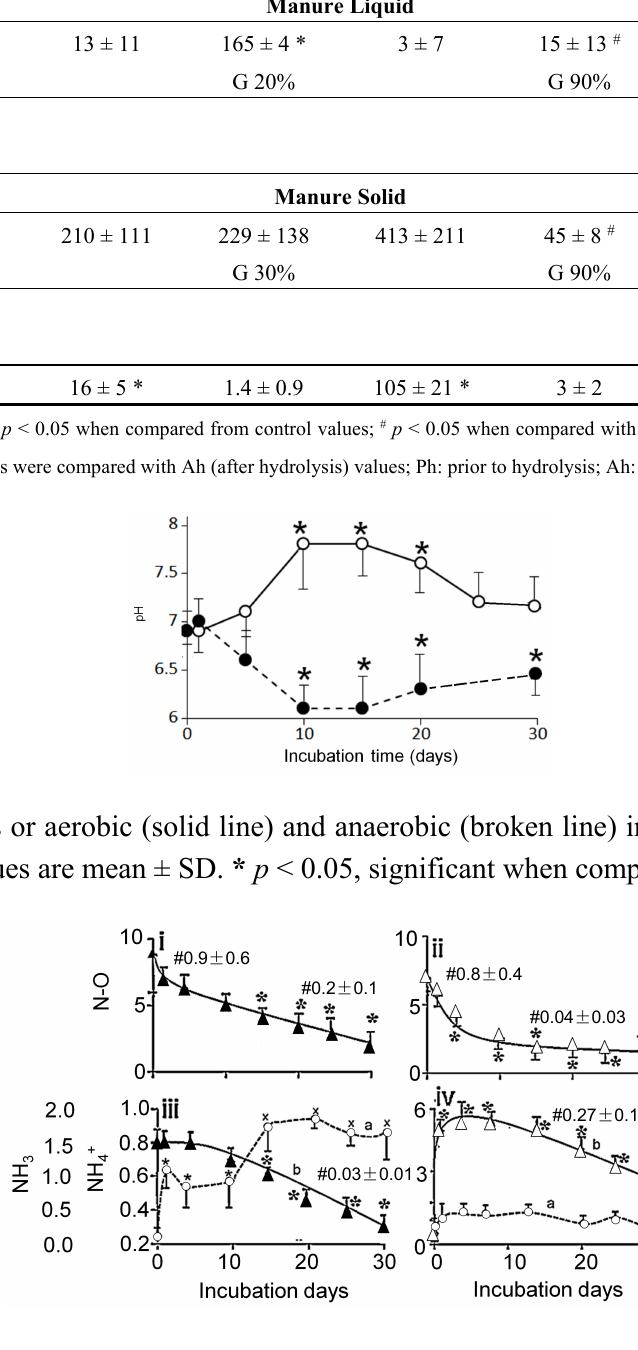
Figure 3. Effects of aerobic and anaerobic incubations on time-course of change in pH, organic nitrogen (O-N), ammonium (NH 4+ ) and ammonia (NH 3 ) in manure samples. i- aerobic and ii- anaerobic : Time-course of change in O-N in manure samples subjected to aerobic and anaerobic incubations; iii- aerobic and iv- anaerobic : Time-course of change in NH 4+ (plot b) and NH 3 (plot a) concentrations in manure samples subjected to aerobic or anaerobic incubations; values are mean ± SD, n = 27, * significant ( p < 0.05) compared with